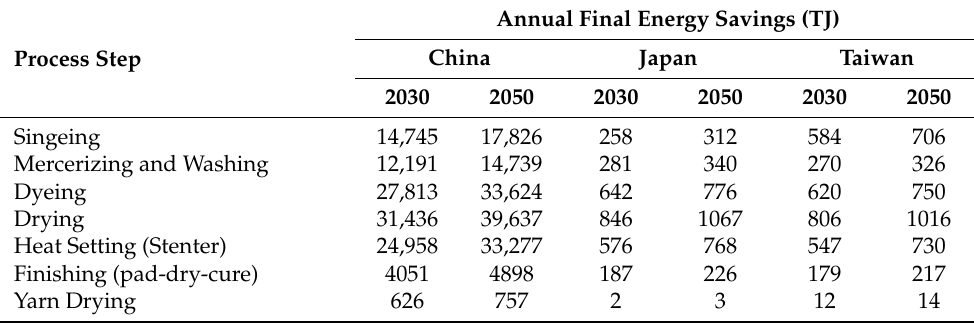
Table 7. Annual final energy savings after electrification of the end-use processes.